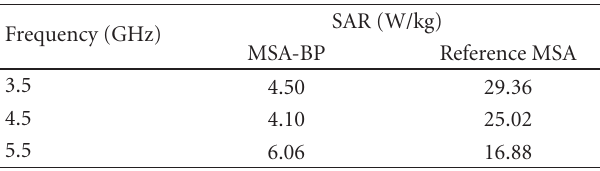
Table 3: SAR values of MSA-BP and reference MSA (input power P = 1 in